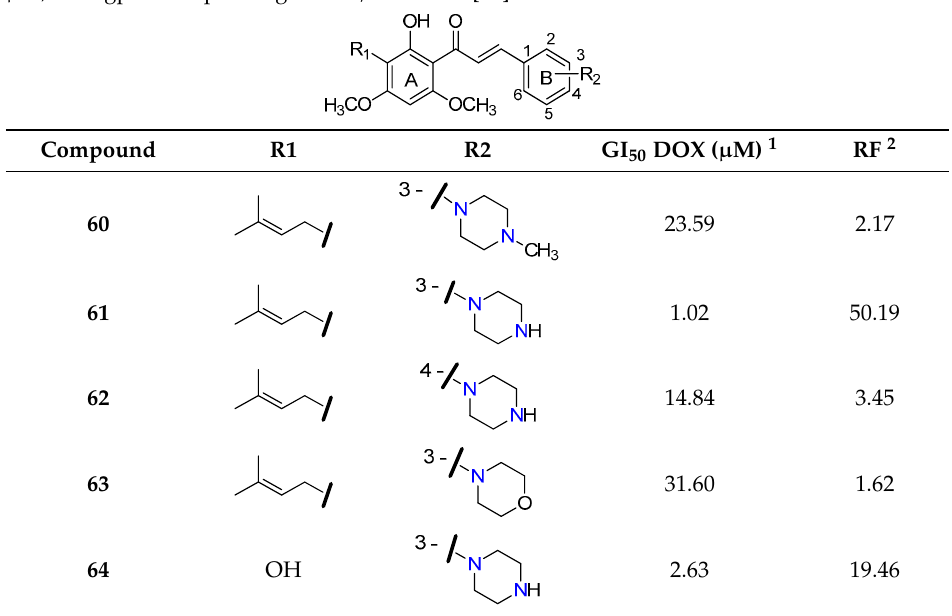
Table 4. Doxorubicin-resistance reversal effects of chalcone derivatives 60 – 64 at a concentration of